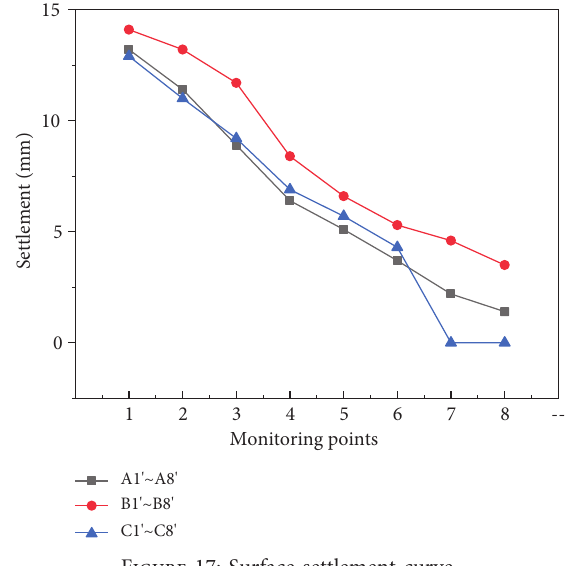
Figure 17: Surface settlement